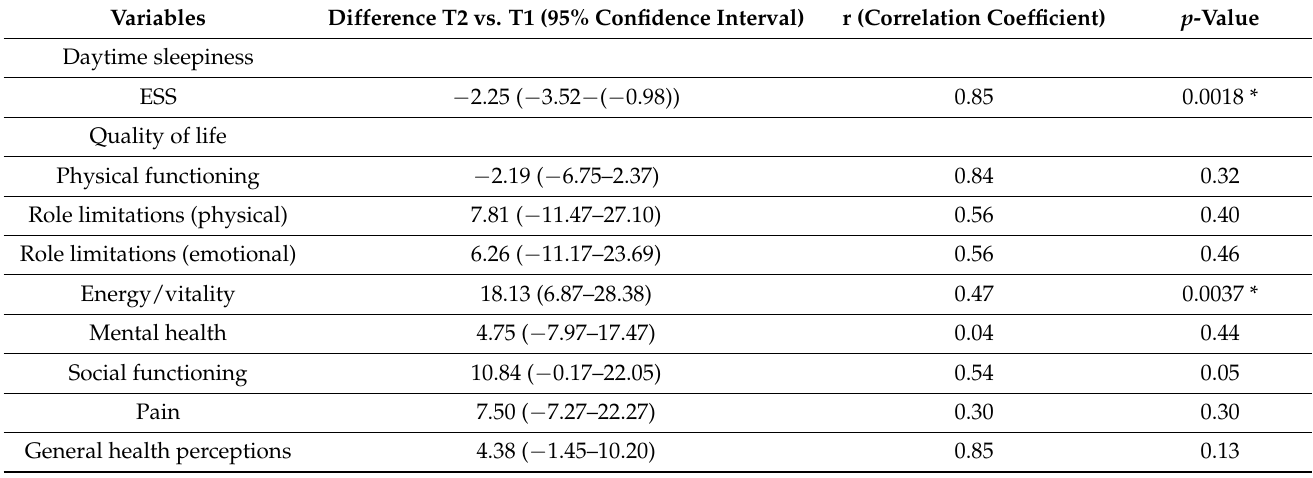
Table 2. Differences in daytime sleepiness and quality of life in the OSA group before (T1) and after (T2) MAD treatment. The estimates are shown with 95% confidence intervals, p -values and correlation coefficients (r). Adjusted for sex and age.